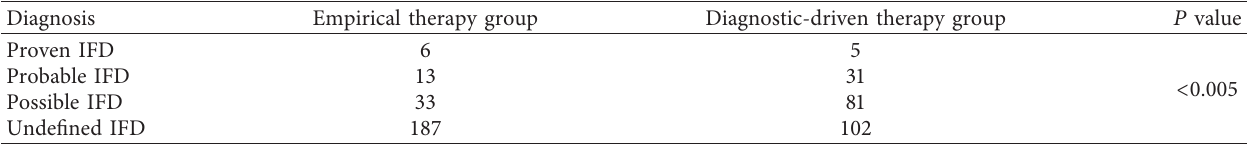
Table 4: Diagnosis in the empirical therapy or diagnostic-driven therapy groups.